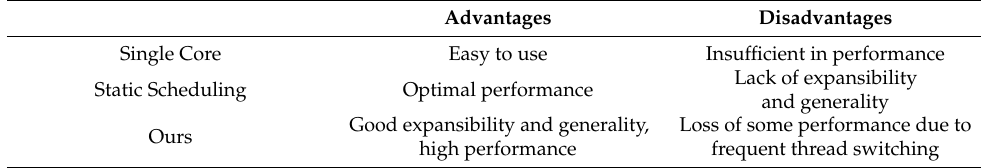
Table 10. Comparison of advantages and disadvantages of each